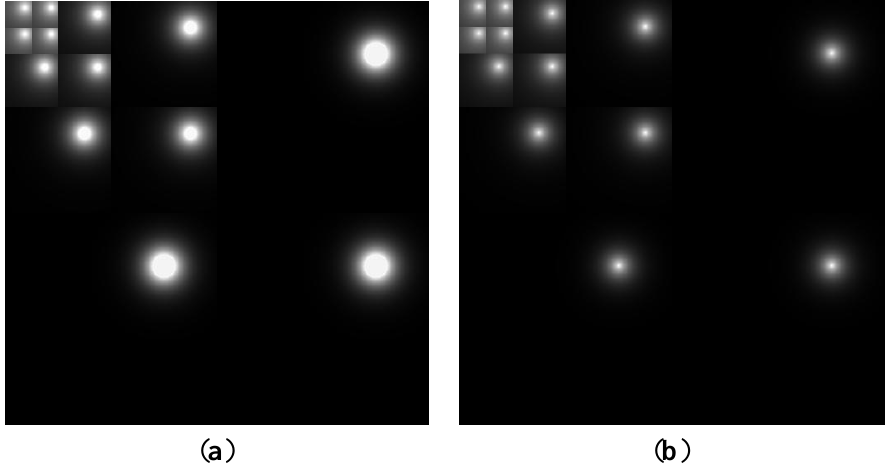
Figure 2. Foveation-based contrast sensitivity mask in wavelet domain: ( a ) using the circle region considering the gaze position with average gaze error of 1.12° [11]; ( b ) using the gaze position that is determined based on the maximum edge magnitude inside the circle region (proposed